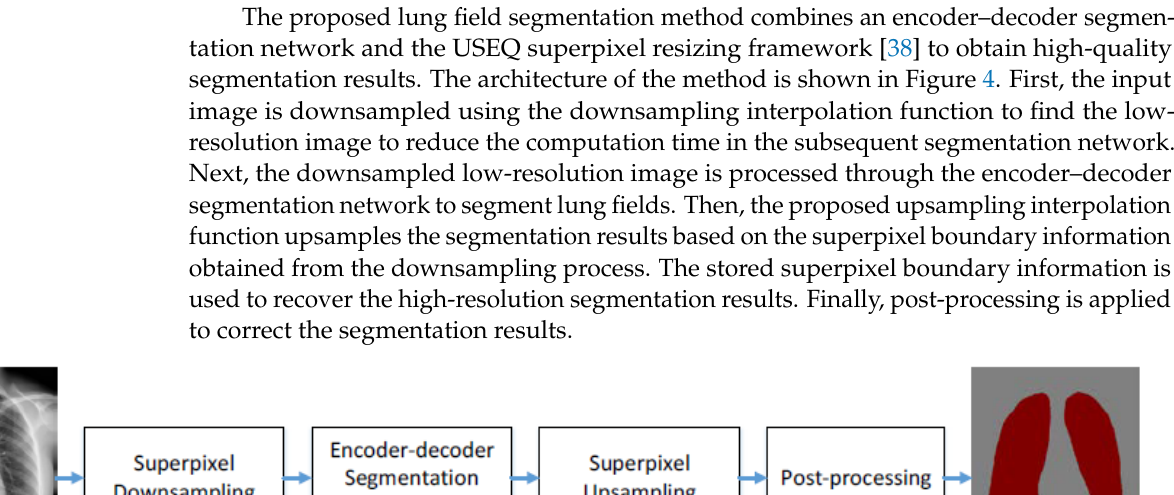
Figure 4. Overview of the proposed lung field segmentation method.